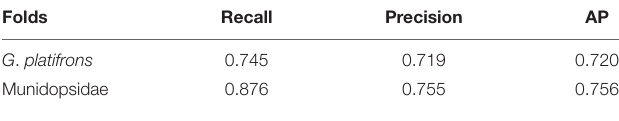
TABLE 4 | Experimental results of the dominant associated